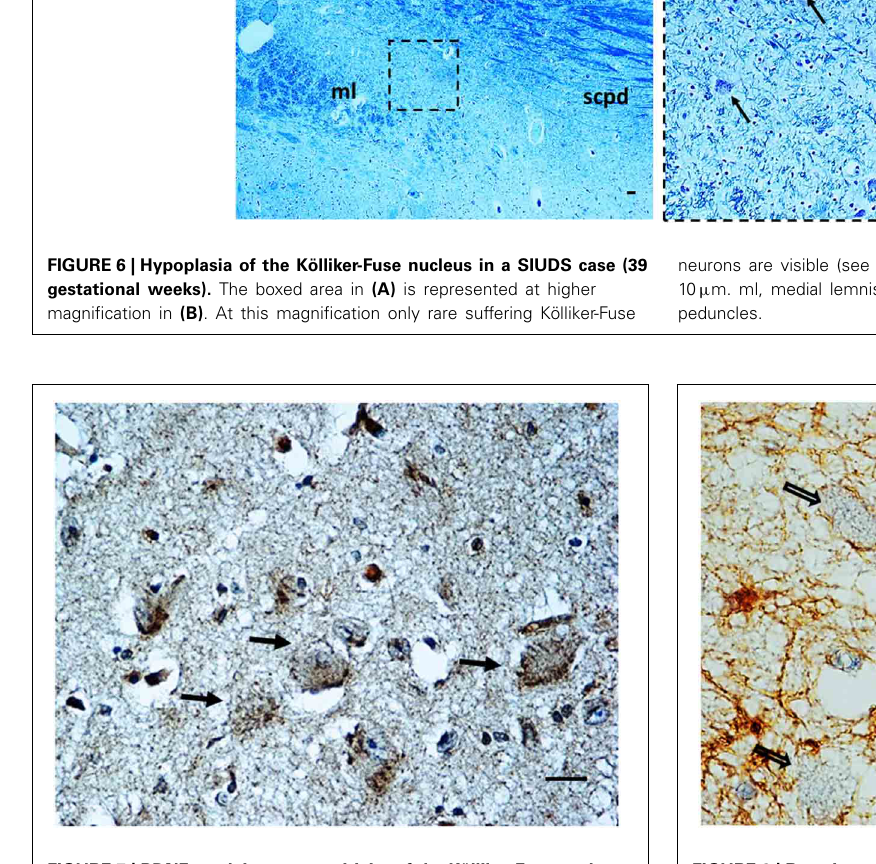
FIGURE 8 | Reactive astrocytes (see full arrows) in the Kölliker-Fuse area in a SIDS case (2 month-old). These cells are characterized by high-level expression of GFAP immunoreactivity in both hypertrophic cell bodies and processes that appear striking increased in number, length and thickness. Empty arrows indicate some of the large GFAP-immunonegative large neurons of the Kölliker-Fuse nucleus. GFAP immunohistaining. Scale bar = 10 µ